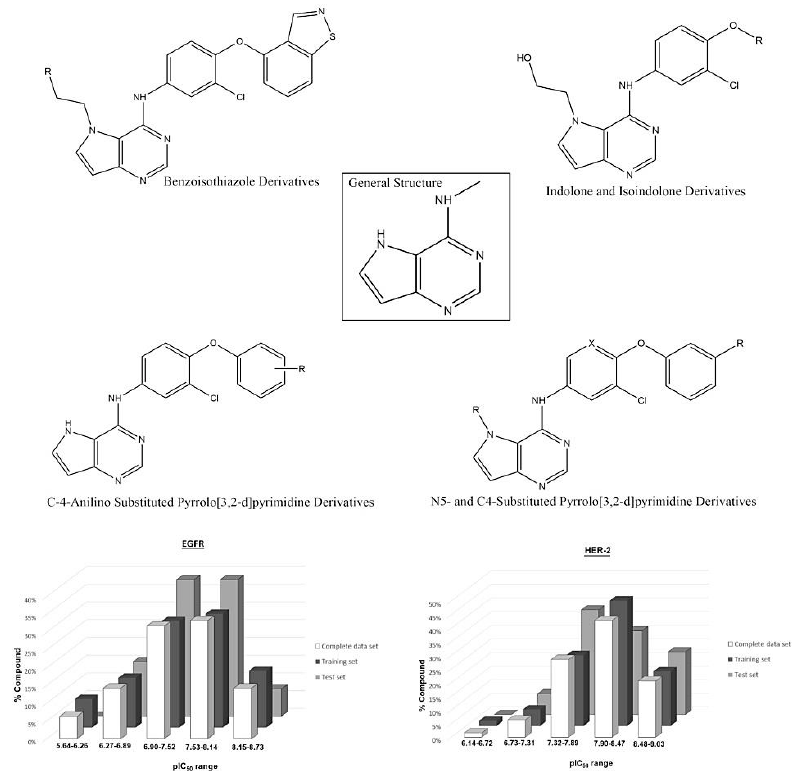
Figure 10. General structure of the studied compounds and some selected ligands, as well as the distribution of pIC 50 for the training and test sets for each biological target.